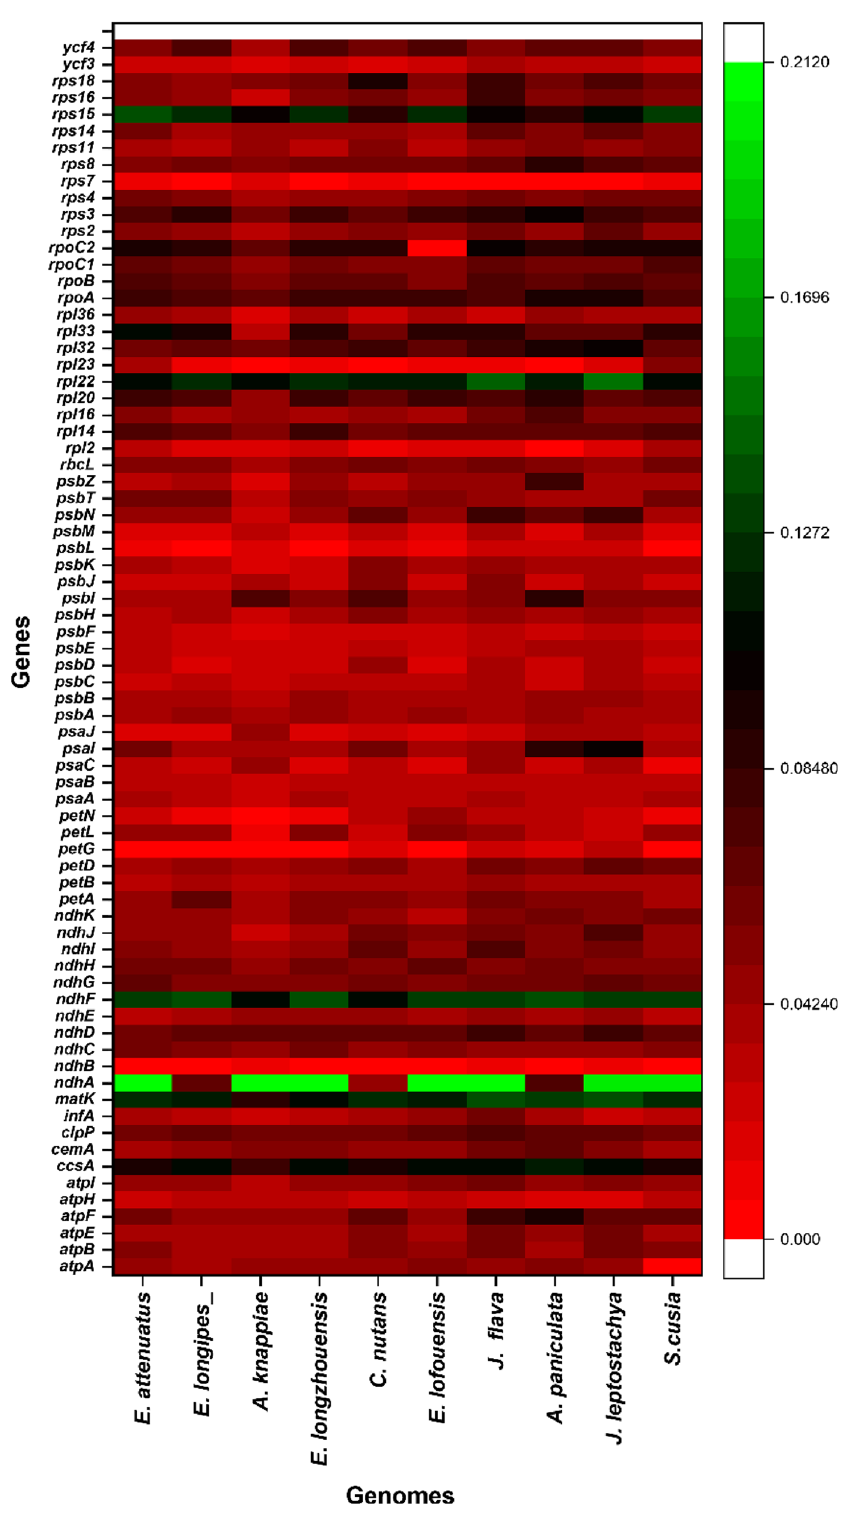
Figure 2. Heatmap of pairwise gene divergence in the chloroplast genome sequence of A. marina. The highly divergent genes are represented with light and green color depending on the divergence